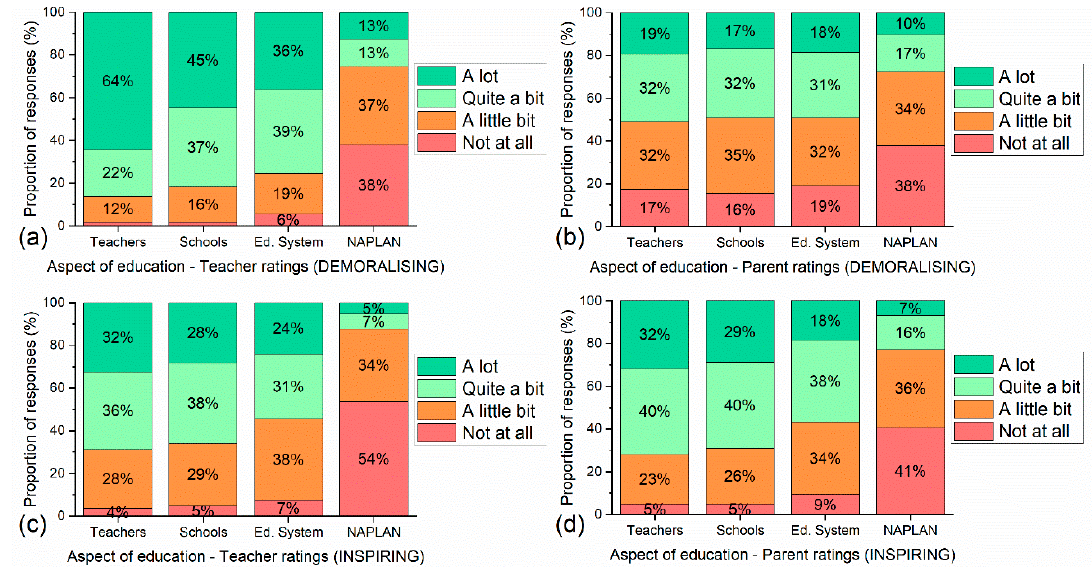
Figure 4. The extent of demoralisation felt upon hearing/reading negative news stories about education for ( a ) teachers and ( b ) parents. Additionally, the extent of inspiration felt upon hearing/reading positive news stories about education for ( c ) teachers and ( d ) parents.